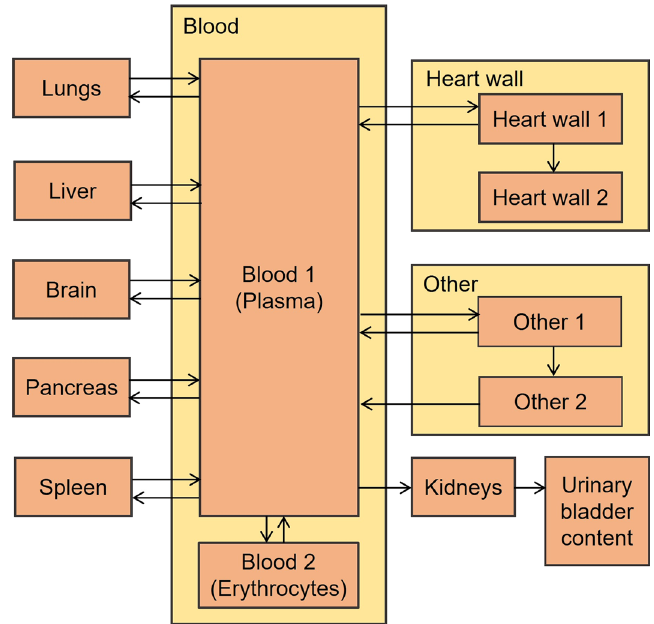
Fig. 1 Structure of the proposed biokinetic model for 2‑[ 18